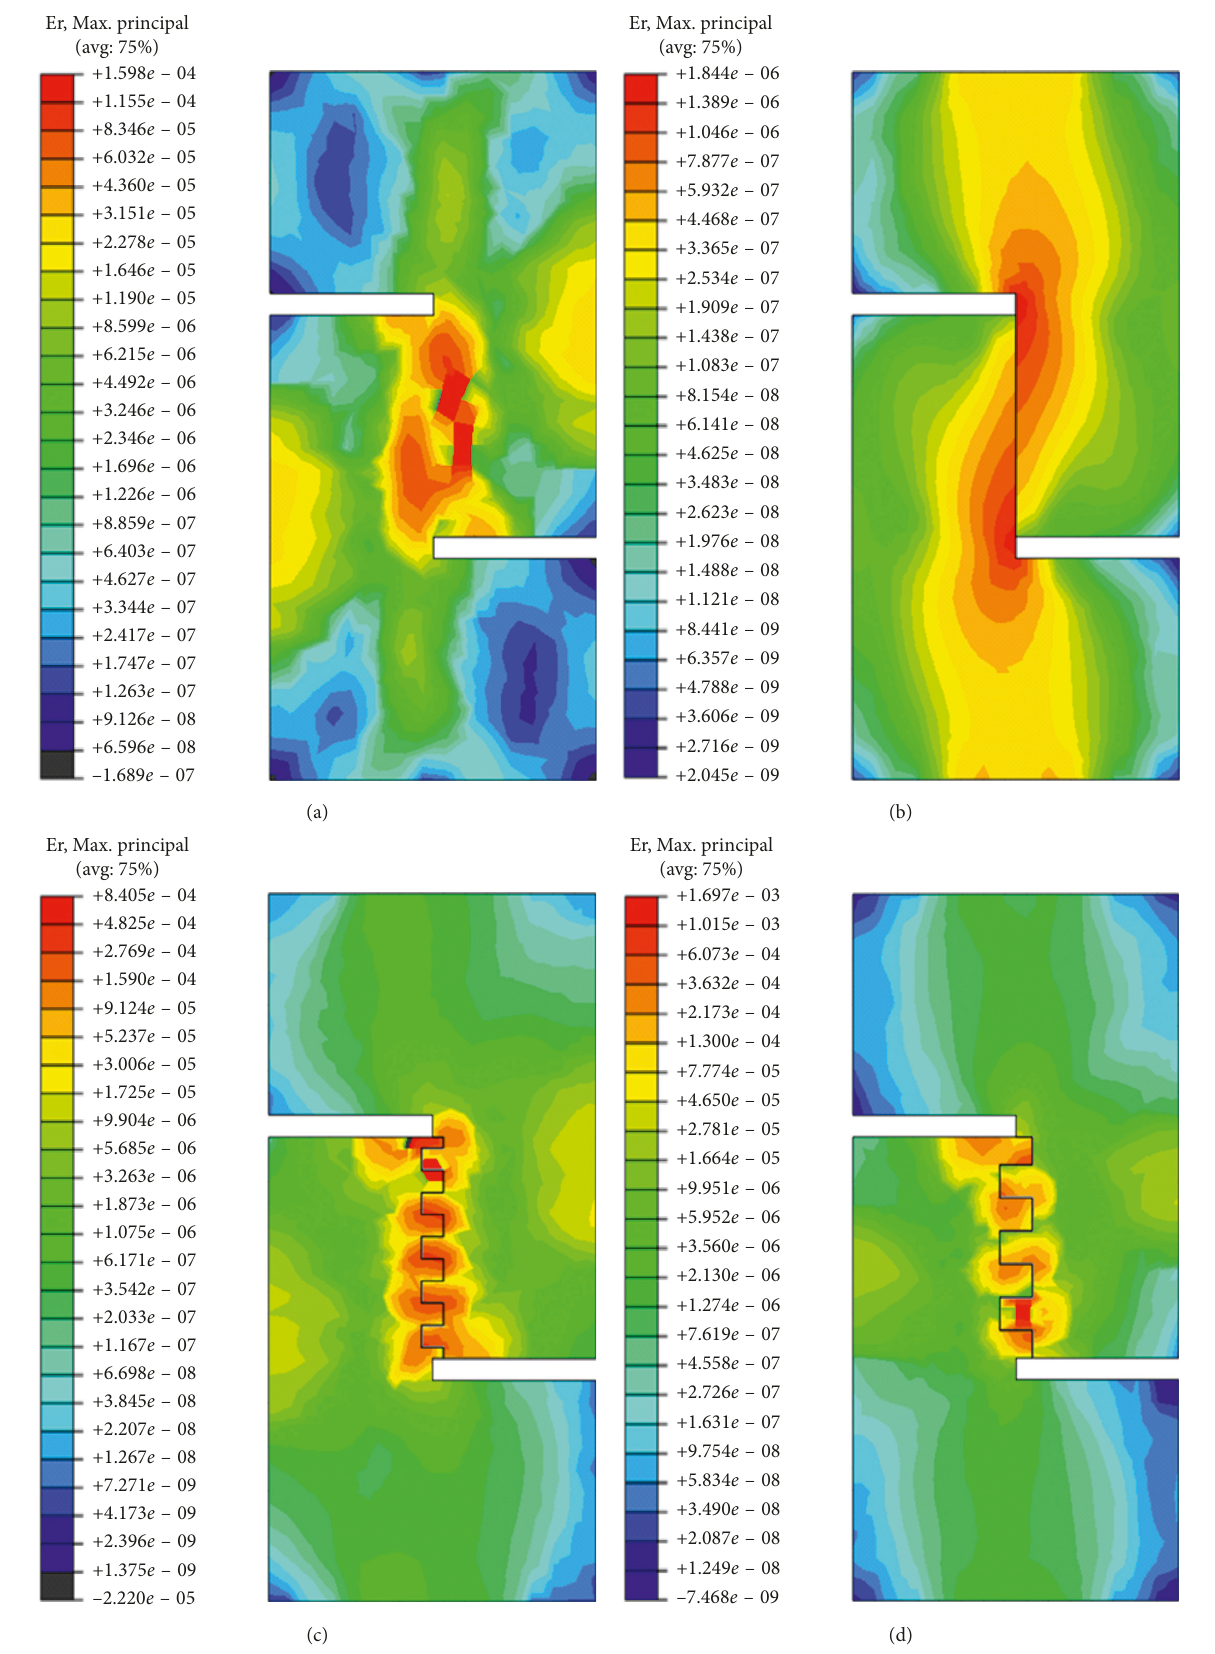
Figure 17: Analysis results (maximum principal strain rate): (a) MN-0; (b) VC-0; (c) GR-20; (d)